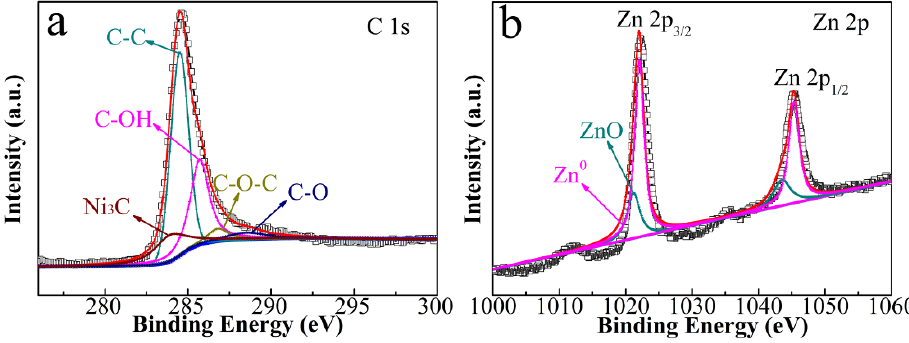
Figure 5. XPS spectra of 5% CNT composite: the deconvolution of ( a ) C1s, ( b ) Zn2p spectra.